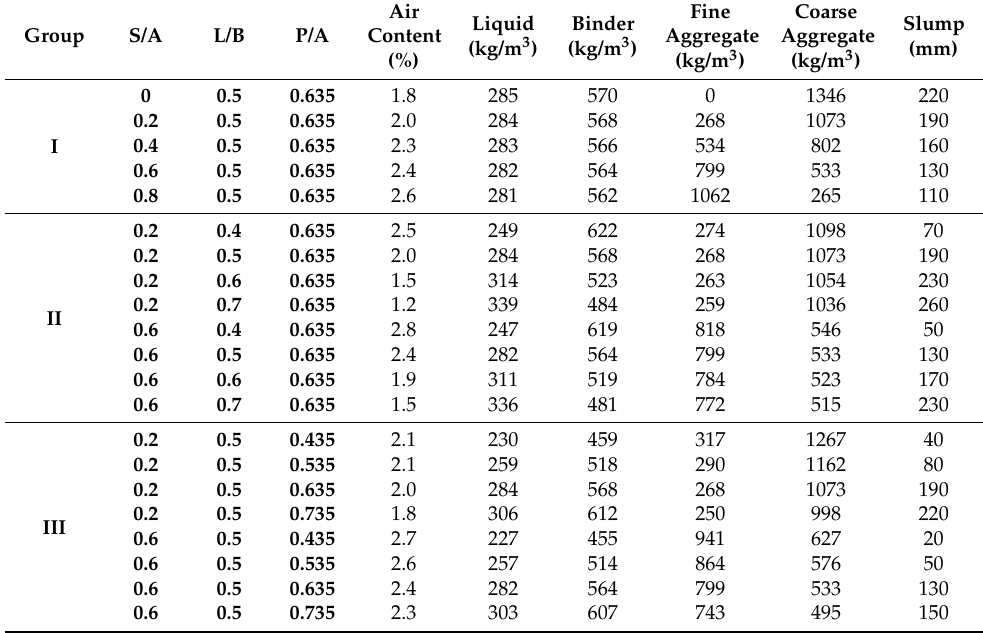
Table 2. Mixture